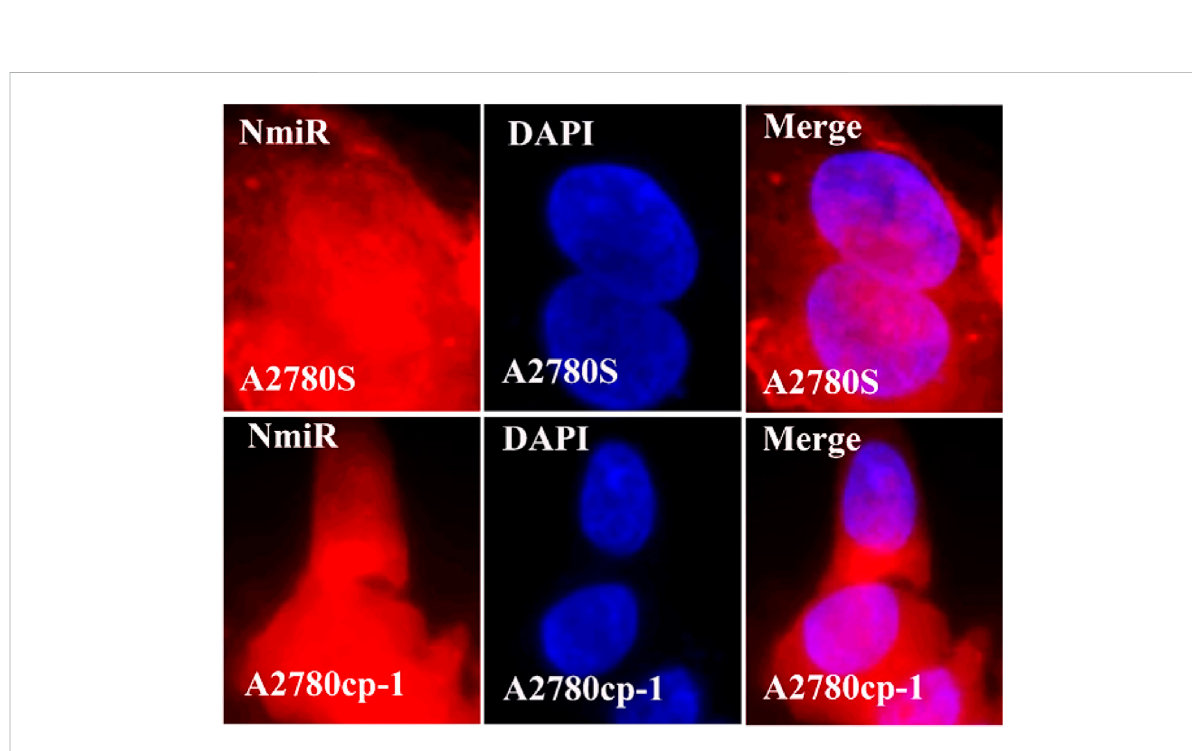
FIGURE 8 The uptake images of niosomal miRNA by A2780s and A270cp-1 cells after incubating for 4